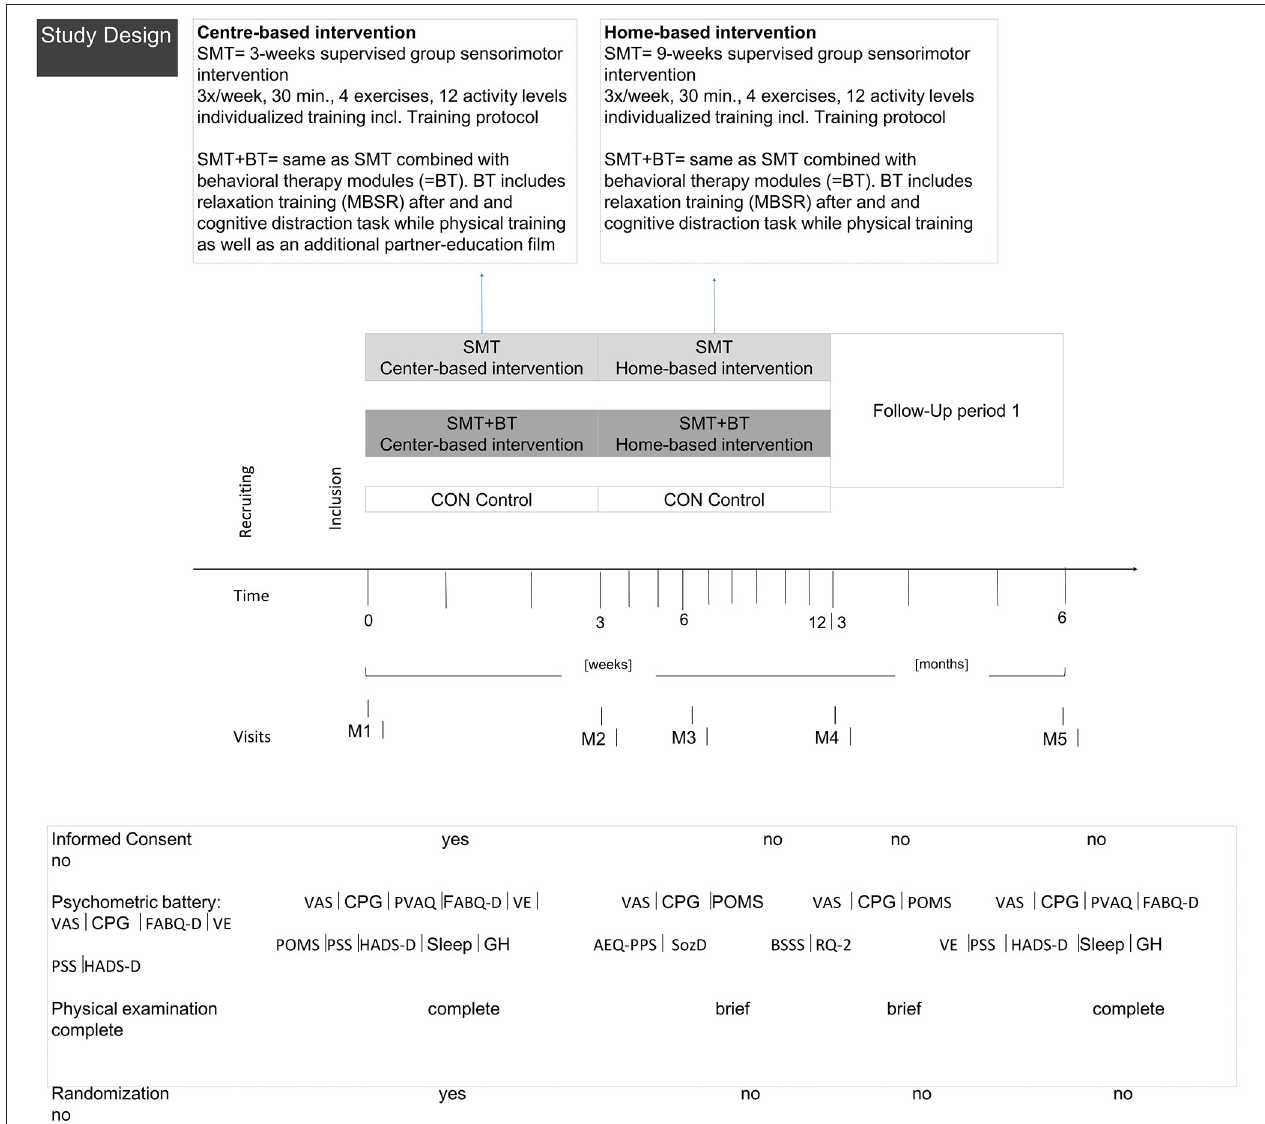
FIGURE 3 | Overview of the study